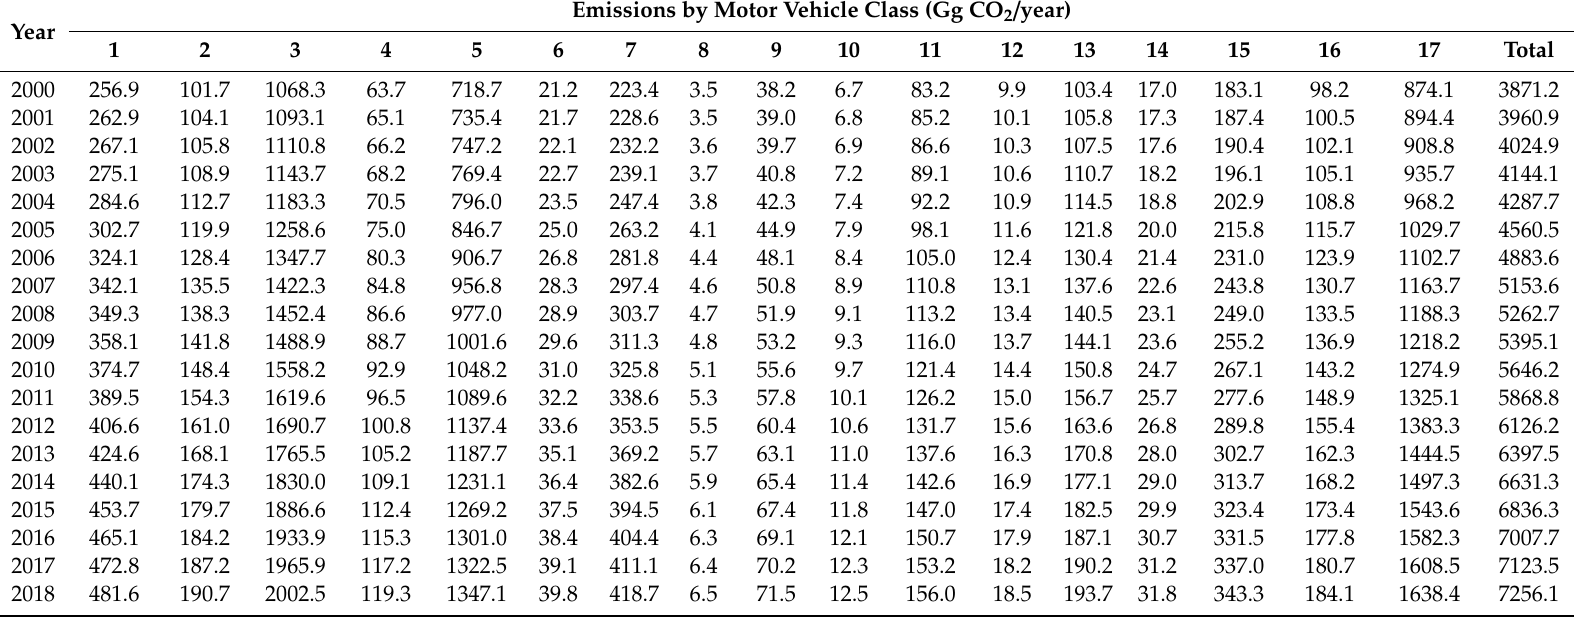
Table 4. Annual CO 2 emissions per motor vehicle class from year 2000 to